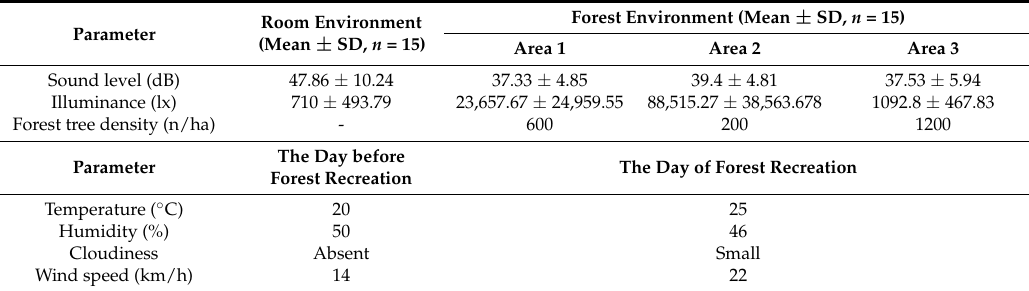
Table 2. Physical and meteorological parameters during the forest therapy experiment.